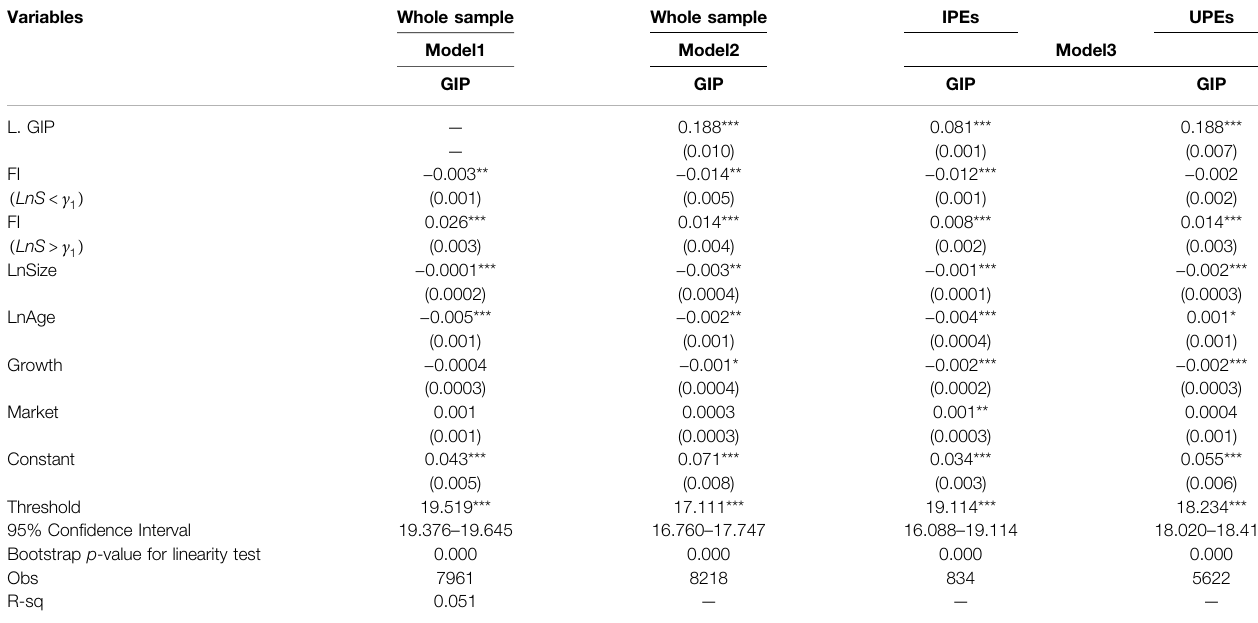
TABLE 5 | Regression on the static and dynamic panel threshold effect. Variables Whole sample Whole